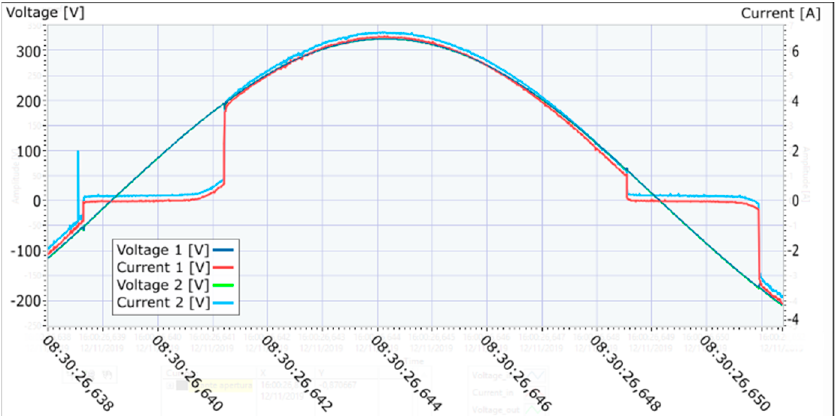
Figure 15. Deformation of the arc (using the Bourns 2049-14 surge arrester).